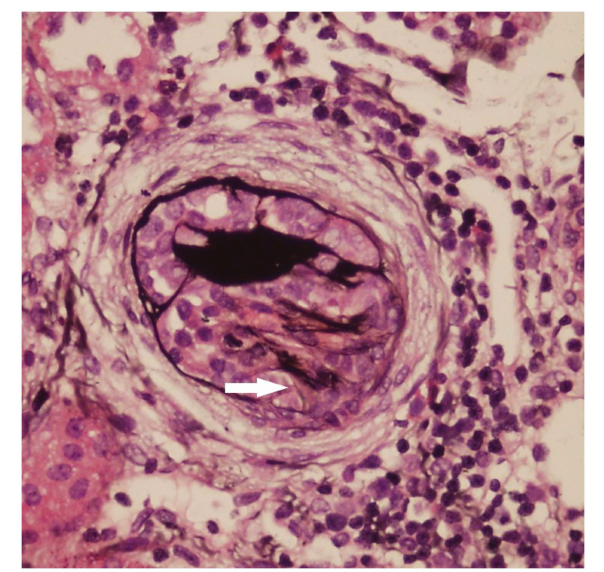
matrix had mild diffuse hyperplasia. One cellular crescent formation can be seen (white arrow).